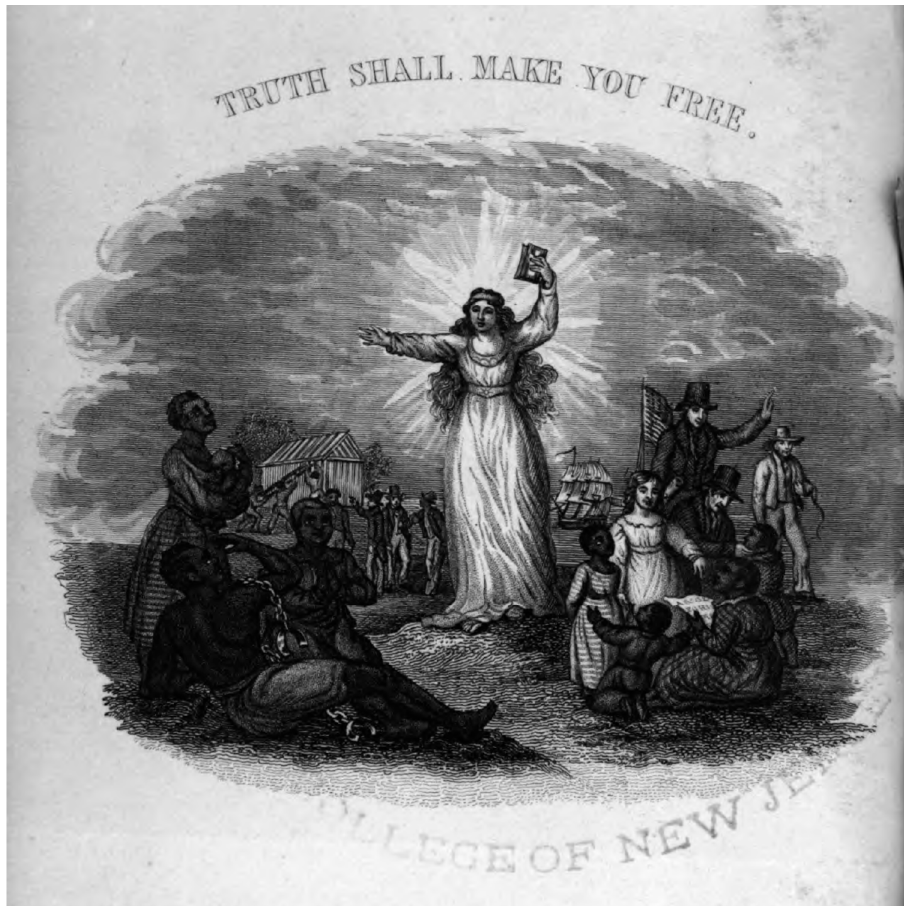
Figure 2. Frontispiece to the first Liberty Bell (for 1839), engraved by Patrick Henry Reason.